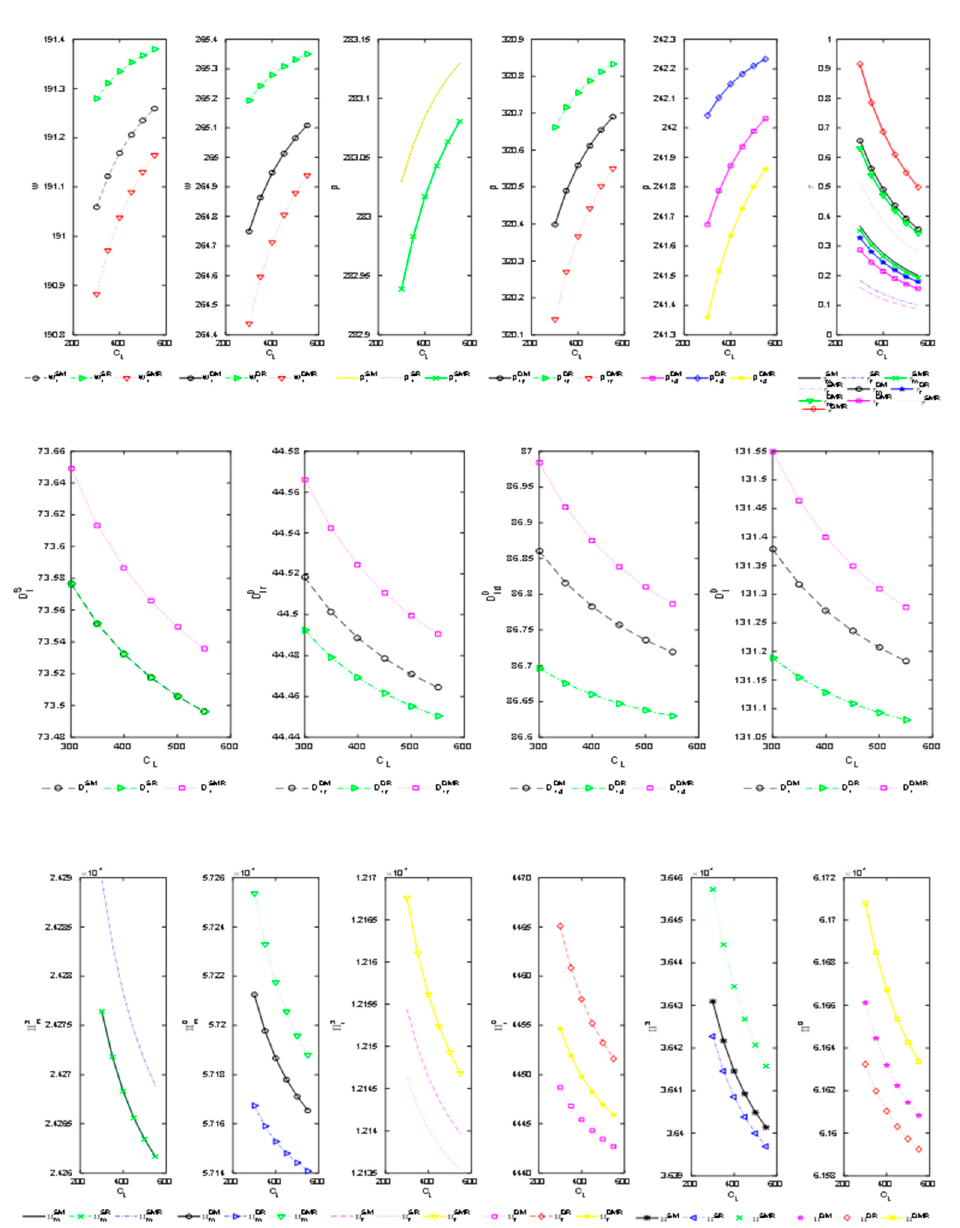
Figure 7. Changes of the wholesale price/selling price/collecting rate/market demand/profit with C L .